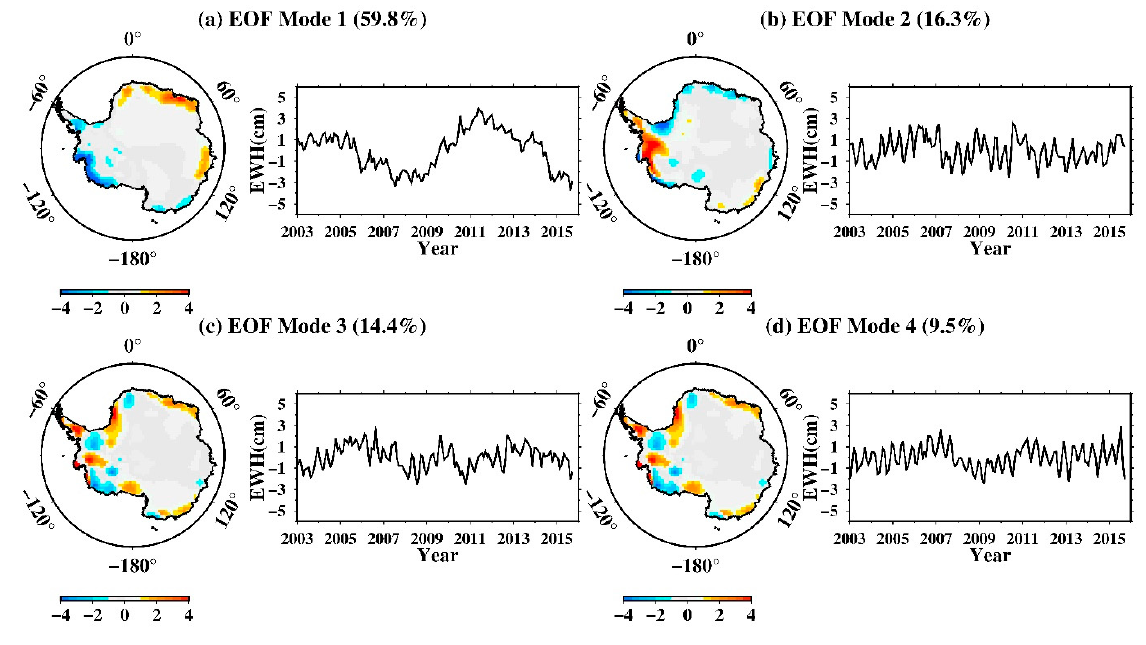
Figure 4. EOF-mode solutions (spatial patter and time series) of the (non-seasonal) mass variation over Antarctica from GRACE data. ( a – d ) Modes 1-4 (Mode 1 representing ACD). The spatial patterns are normalized with respect to standard deviation; the time series manifests equivalent water- thickness in cm.